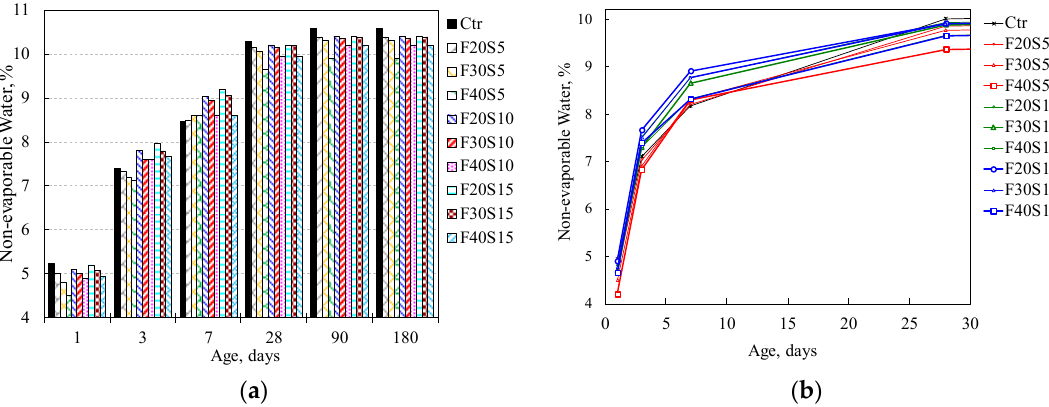
Figure 10. Non-dehydrated water content in control and ternary blended paste systems with w/b ratio 0.3, mist cured, at ages ( a ) 1, 3, 7, 28, 90 and 180 days ( b ) 1, 3, 7 and 28 days.